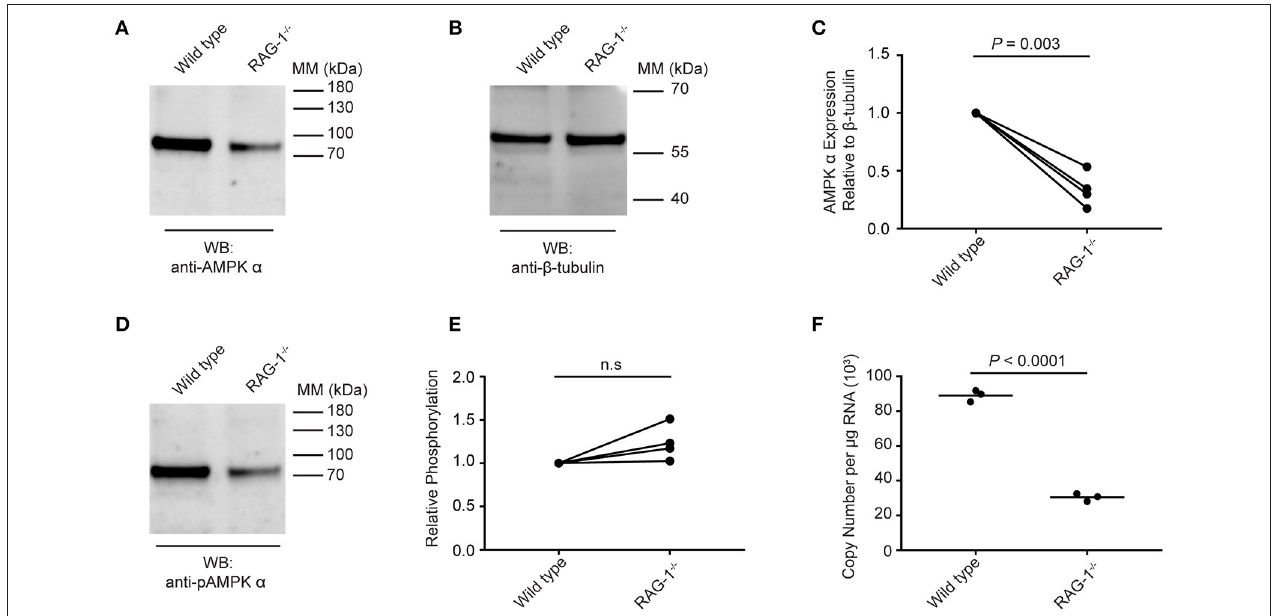
FIGURE 6 | Expression and phosphorylation of schistosome AMPK α in RAG-1 − / − mice. Lysates were prepared from schistosomes recovered from wild type (C57BL/6) and RAG-1 − / − mice and probed by Western blot with anti-AMPK α (A) and anti- β -tubulin (B) antibodies. (C) The intensity of the anti-AMPK α signal relative the anti- β -tubulin signal for each sample was determined, and the signals normalized to that obtained with worms from wild type mice (displaying results from four independent biological replicates). (D) Lysates of schistosomes from wild type and RAG-1 − / − mice were probed by Western blot with anti-pAMPK α antibody. (E) The intensity of the anti-pAMPK α signal relative the anti-AMPK α signal [from (A) ] for each sample was determined, and the signals normalized to that obtained with worms from wild type mice (displaying results from four independent biological replicates). (F) AMPK α transcripts in S. mansoni worms isolated from wild type and RAG-1 − / − mice were quantified using quantitative real-time RT-PCR. WB, indicates the antibody used for Western blotting; Positions of molecular mass (MM) markers, in kilodaltons (kDa), are indicated to the right of each blot.